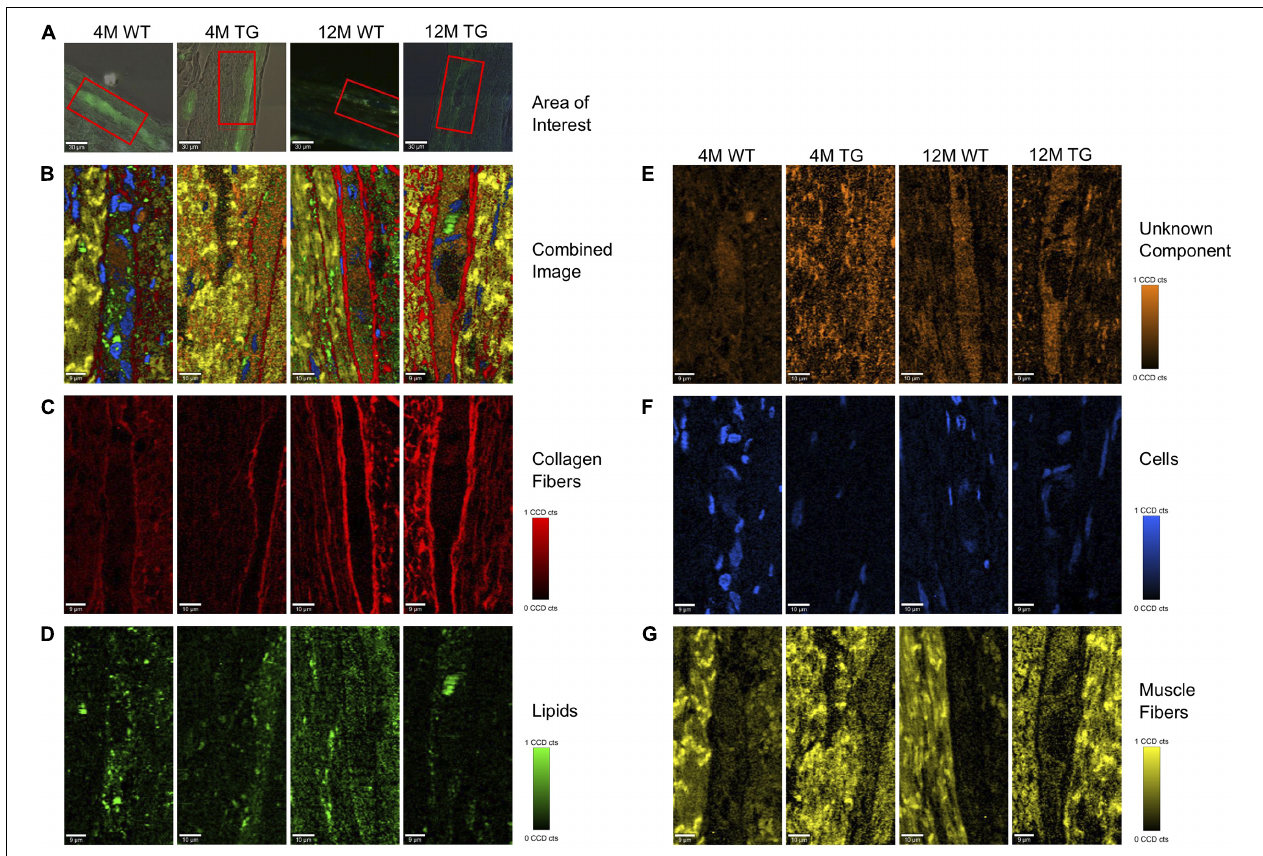
FIGURE 5 | True component analysis (TCA) of selected areas in the colon of WT and TG rats. (A) The measured area is shown in red boxes. (B) The combined image of the components is shown. (C) The separated components through TCA were collagen fibers in red, (D) lipids in green, (E) unknown component in orange, (F) cells in blue, and (G) muscle fibers in yellow. The CCD count interval was listed for all the